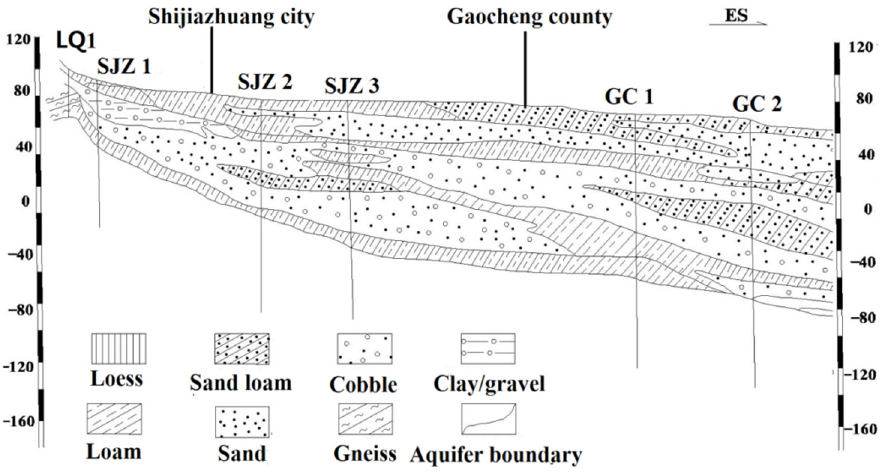
Figure 1. Monitoring sites of groundwater in Hutuo River alluvial-pluvial fan.